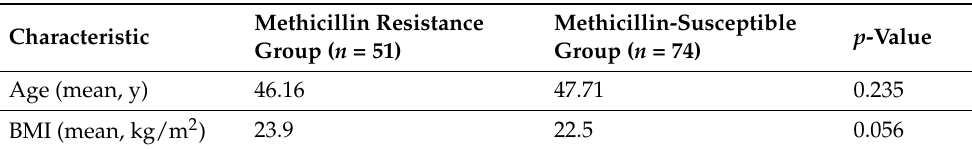
Table 3. Statistical analysis for neoadjuvant chemotherapy between the methicillin resistance and methicillin-susceptible groups .